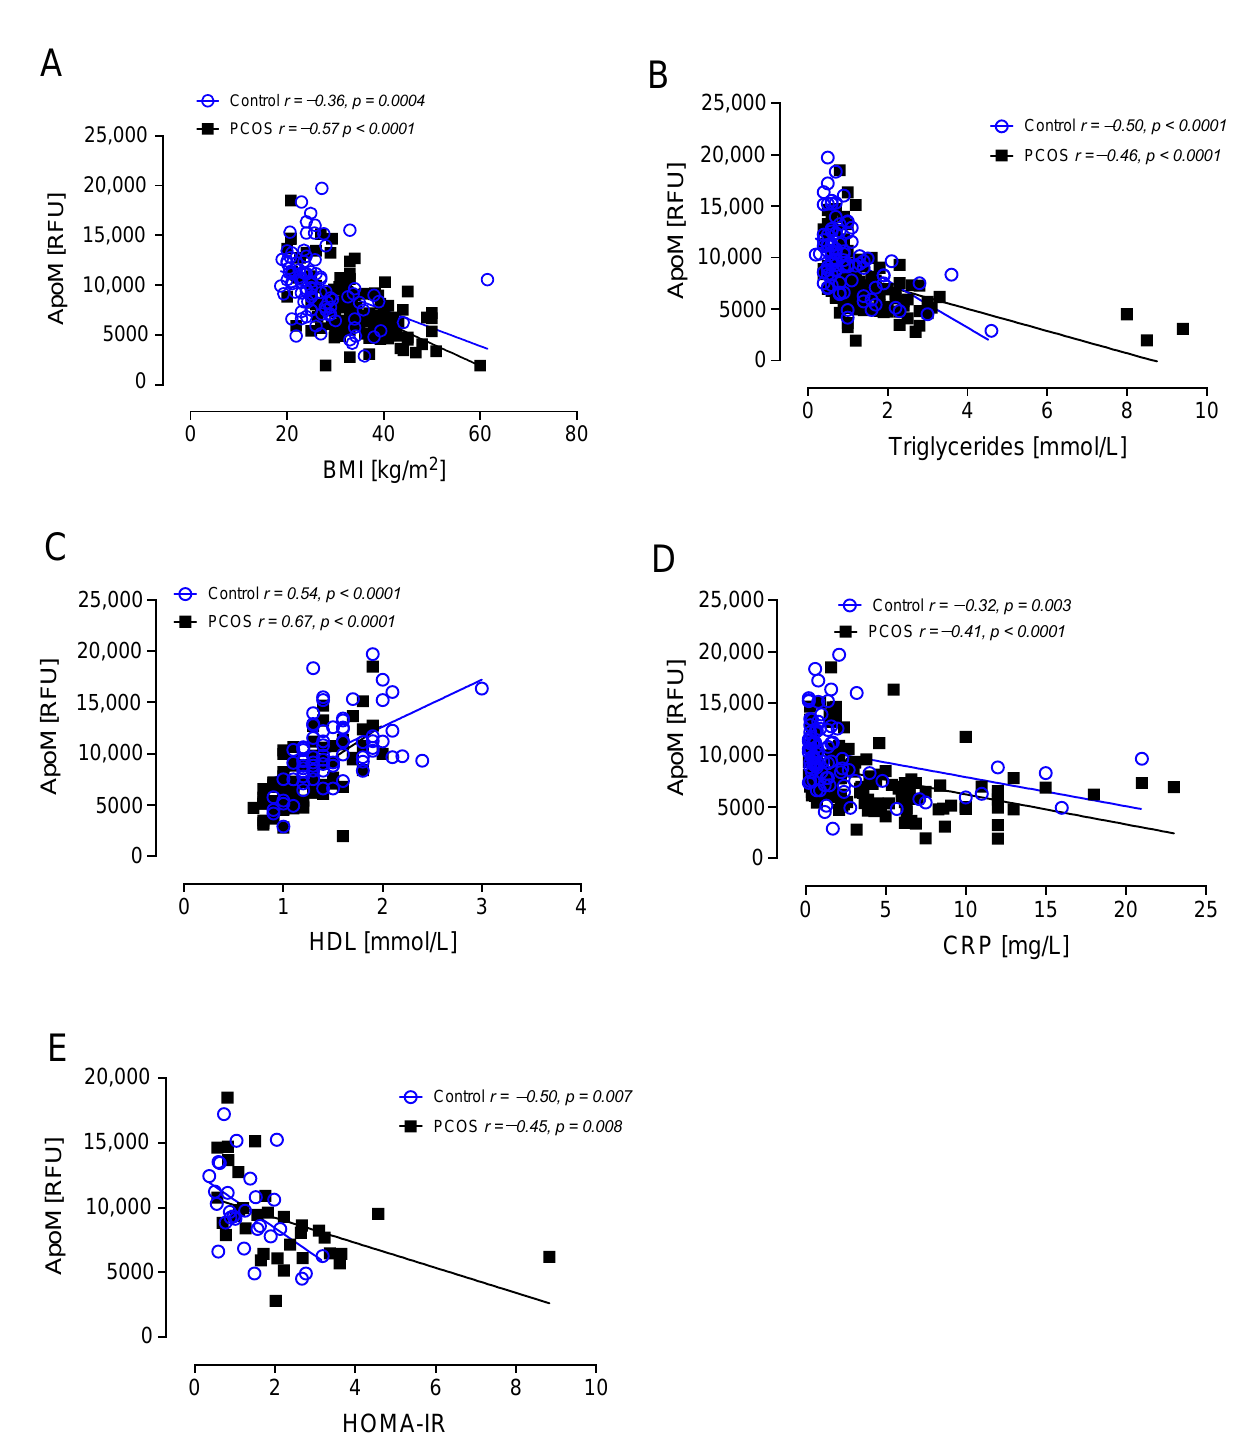
Figure 5. ApoM correlated significantly with BMI in controls and PCOS ( A ), triglycerides in controls and PCOS ( B ), HDL in controls and PCOS ( C ), CRP in controls and PCOS ( D ), and HOMA-IR in controls and PCOS ( E ).